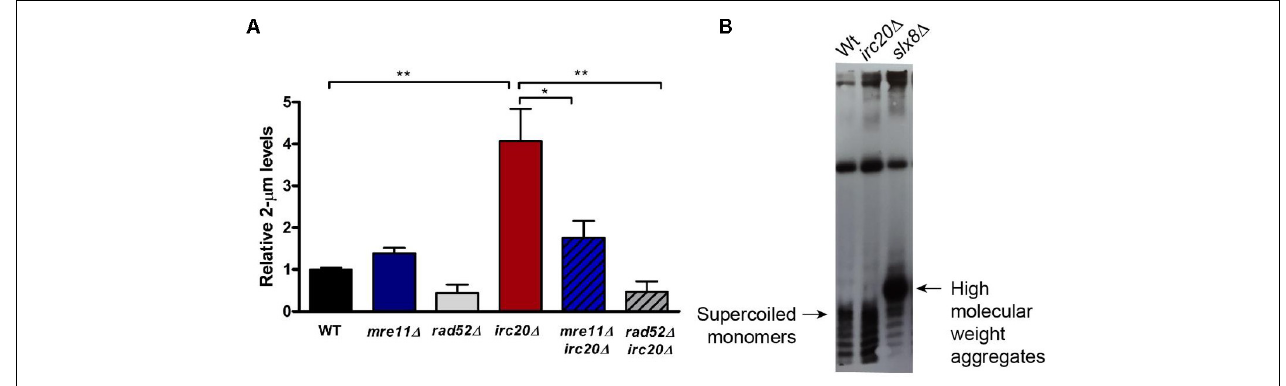
FIGURE 2 | The absence of Irc20 increases the endogenous 2- µ m plasmid levels without forming HMW aggregates. (A) The levels of endogenous 2- µ m plasmids in WT, irc20 (cid:49) , mre11 (cid:49) , rad52 (cid:49) , mre11 (cid:49) irc20 (cid:49) , and rad52 (cid:49) irc20 (cid:49) mutants were measured by real-time PCR using primers specific to the 2- µ m plasmid DNA sequence and quantified relative to Y-subtelomeric regions. irc20 (cid:49) mutant showed 4-fold higher levels of the 2- µ m plasmid compared to WT. Double mutants of irc20 with HR repair factors, mre11 and rad52 , showed significantly reduced 2- µ m plasmid levels compared to single irc20 (cid:49) mutant. Five to nine independent cultures were analyzed and values are presented as mean ± SEM. Statistical significance was calculated by two-tailed Student t -test for unpaired samples. One asterisk shows p -value < 0.05 and two asterisks show p -value < 0.01, as compared to WT or irc20 (cid:49) as indicated. (B) Southern blot analysis of DNA isolated from WT, irc20 (cid:49) and slx8 (cid:49) using biotinylated probes specific to 2- µ m sequence. The hybridized probes were then visualized using Chemiluminescent Nucleic Acid Detection Module (Thermo Scientific TM ).